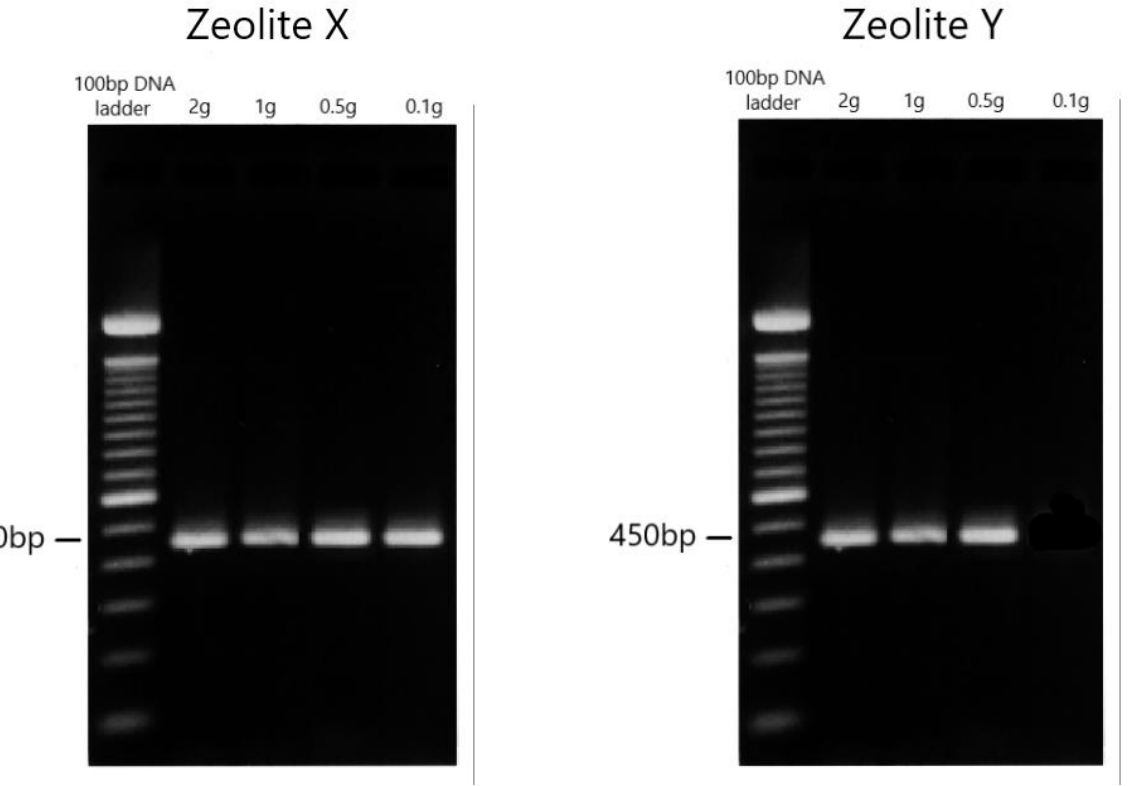
Figure 1. Agarose gel: investigated positivity of water samples for Cryptosporidium parvum with zeolites. Table 1. C. parvum positive water samples after zeolite filtration.